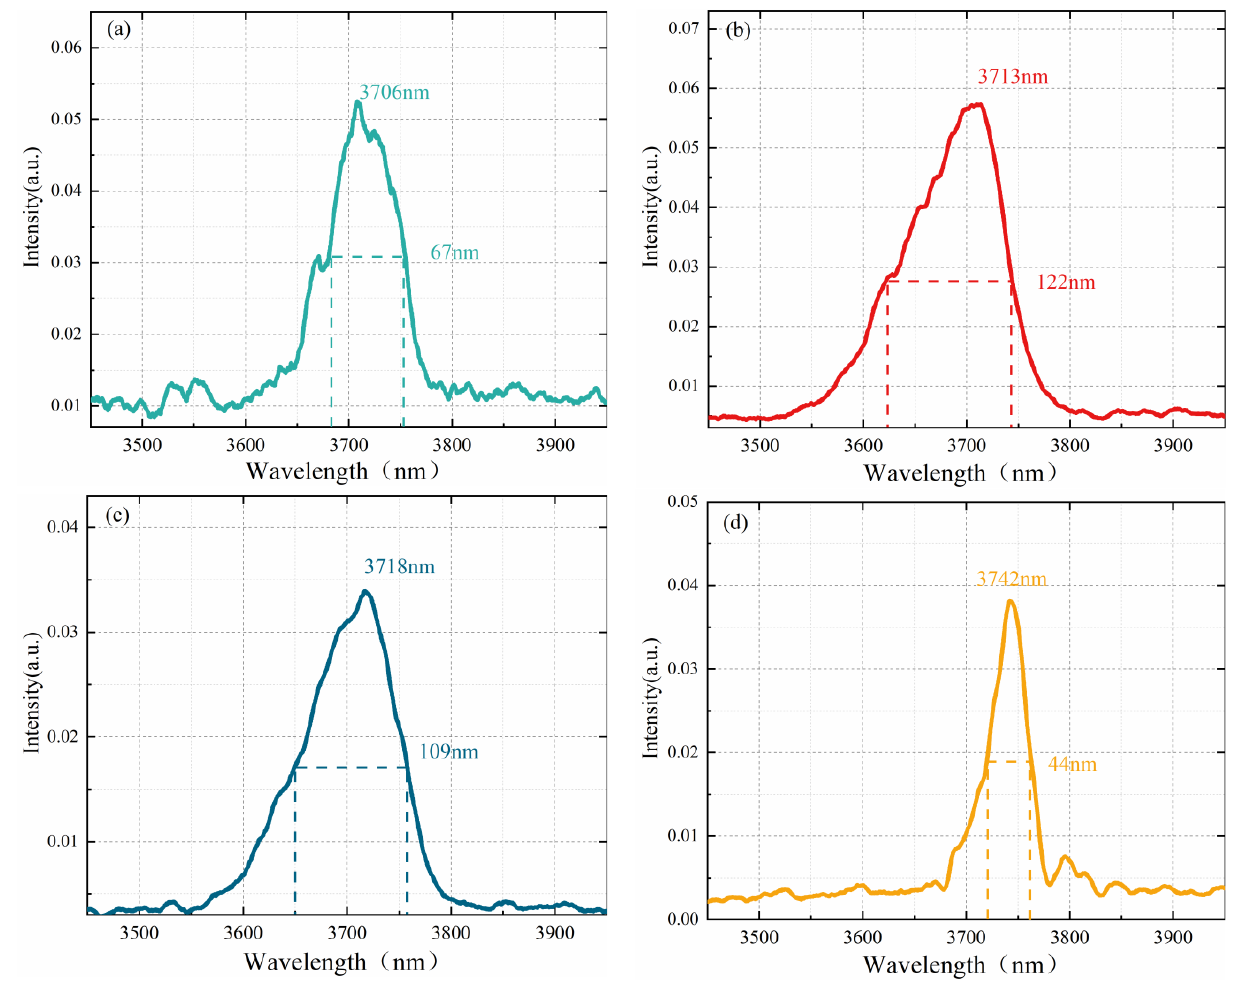
Figure 5. DFG idler spectrum under different types of phase-mismatching with different central wavelengths at ( a ) 3706 nm; ( b ) 3713 nm; ( c ) 3718 nm; ( d ) 3742 nm.